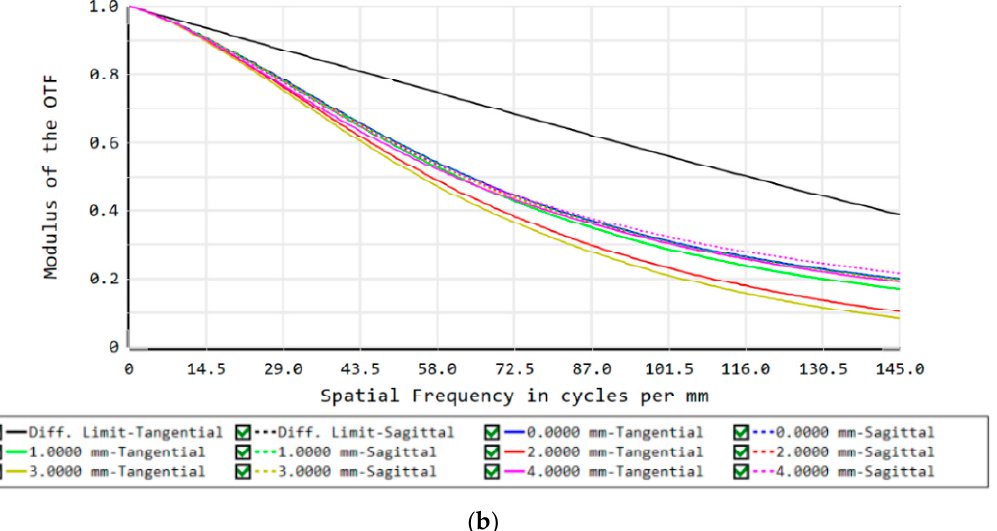
Figure 16. MTF curves of the concentric multi-scale zoom optical system. ( a ) Focal length f = 50 mm, ( b ) Focal length f = 100 mm.